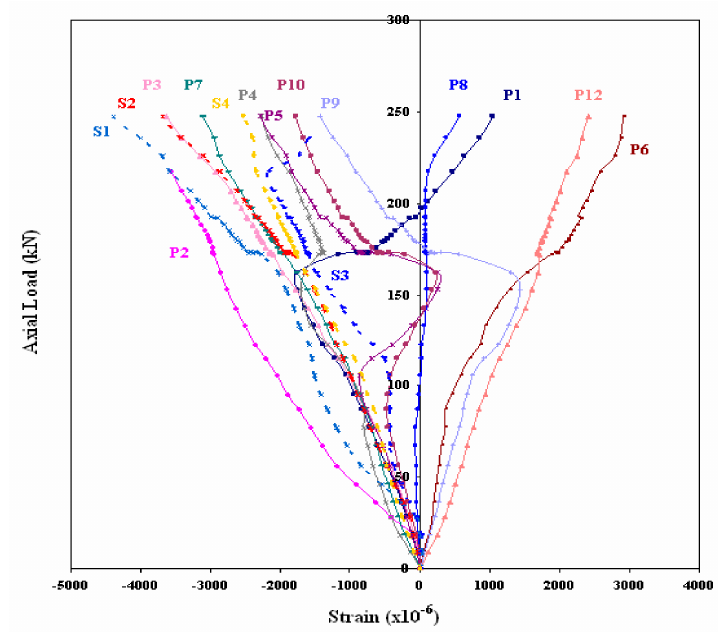
Figure 10. Load–strain behavior of LSTP1.